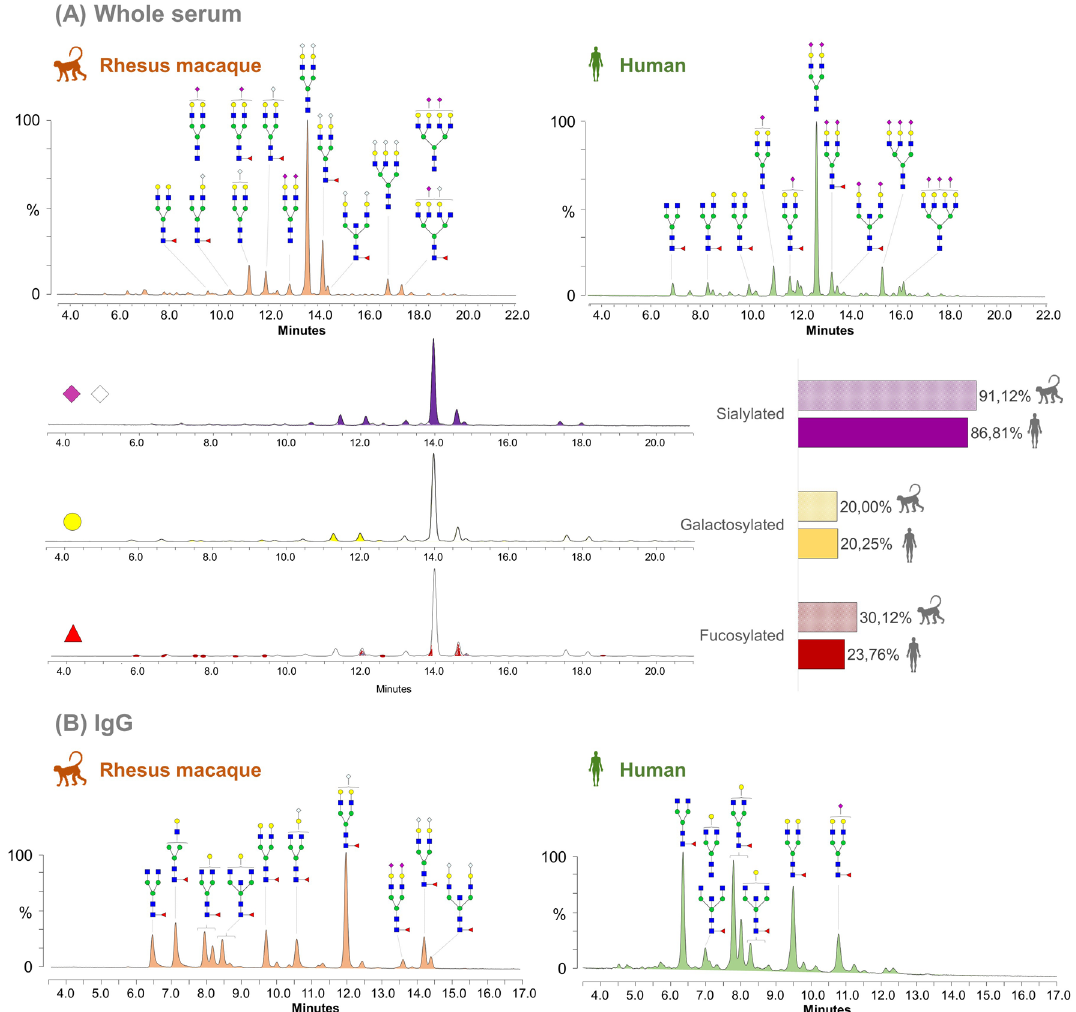
Figure 3. Comparison of rhesus macaque and human HILIC-UPLC profiles of serum ( A ) and IgG ( B ) N-glycans. HILIC-UPLC spectra of rhesus macaque (left) and human (right) are shown for both serum ( A ) and IgG ( B ). N-glycan structures found in the 10 major glycopeaks (based on peak areas) are depicted using the CFG nomenclature (see inset in Fig. 1). Quantification of glycan classes in rhesus macaque serum was determined before and after digestion with α2-3,6,8,9 Neuraminidase A for sialylated structures (purple and grey diamonds), β1-4 Galactosidase S for structures carrying terminal galactose (yellow circle) and with Fucosidase O for core-fucosylated structure (red triangle). Results were compared with similar quantification data conducted previously on human serum 32 and are shown on the bar chart on the